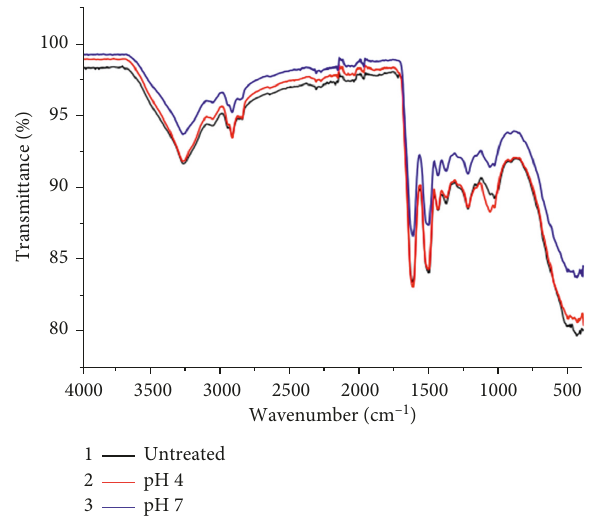
Figure 4: The effect of pH and Analysis of Infrared Spectra of wool fibers after